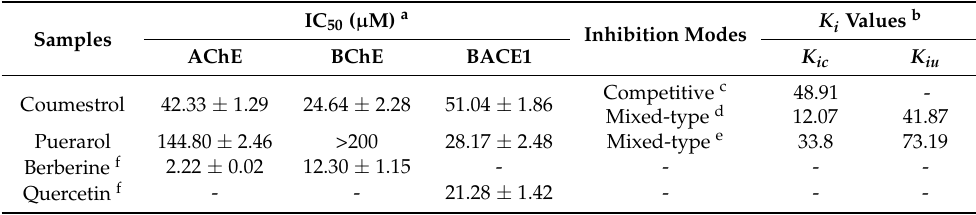
Table 2. Cholinesterases and BACE1 inhibitory activity and enzyme kinetic analysis of coumestrol and